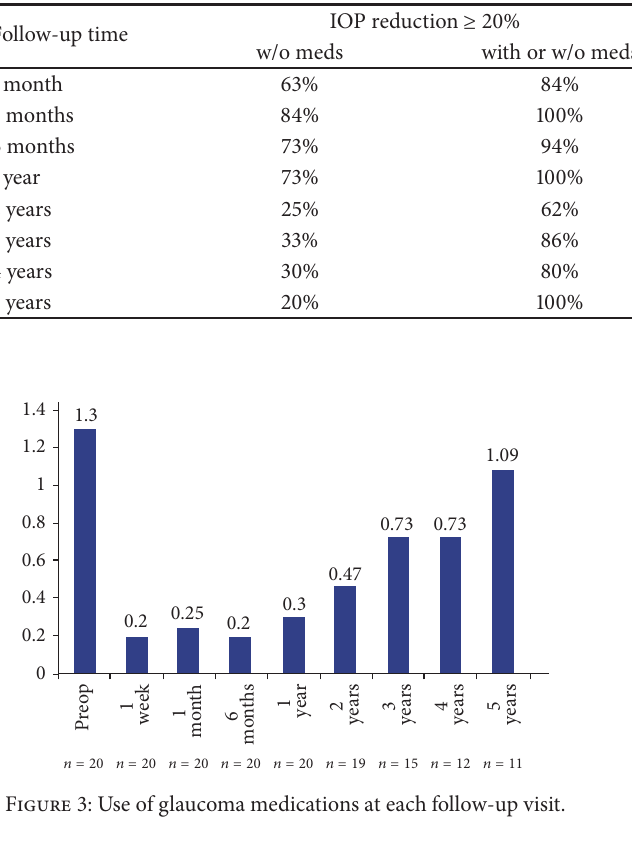
Figure4:Kaplan-Meierplotofthecumulativeprobabilityofsuccess defined as an IOP reduction ≥ 20% regardless of